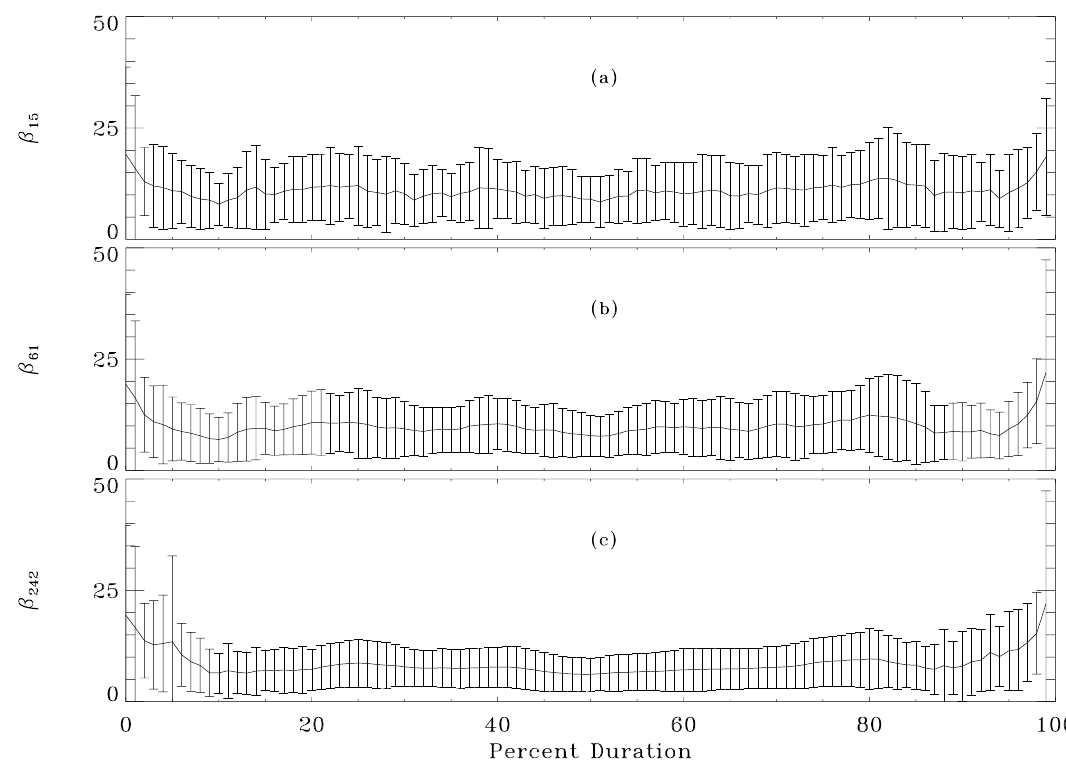
Fig. 1. Family of plots of β vs. %-duration for three 1 T s (from top to bottom: 15, 61, and 242min, as shown by the subscripts on the β ’s on the left). The central curves are the averages over the 50 MCs, and the lengths (top-to-bottom) of the vertical bars at the points represent twice their